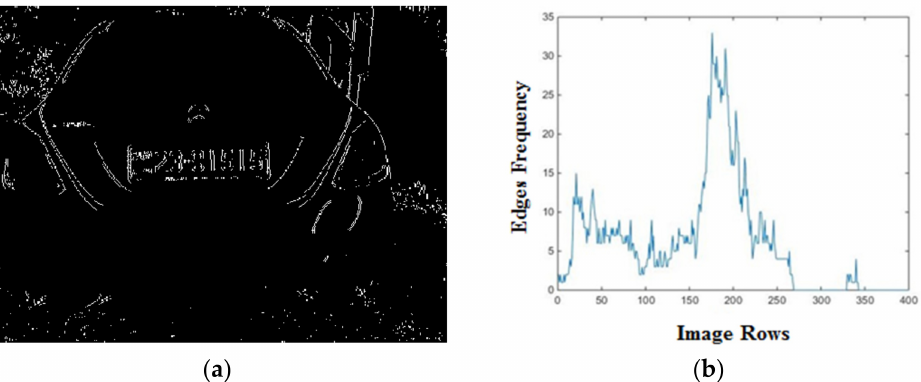
Figure 6. An example of a vertical-edge image and projection histogram of its vertical edges. ( a ) A vertical-edge image. ( b ) Projection histogram of the vertical